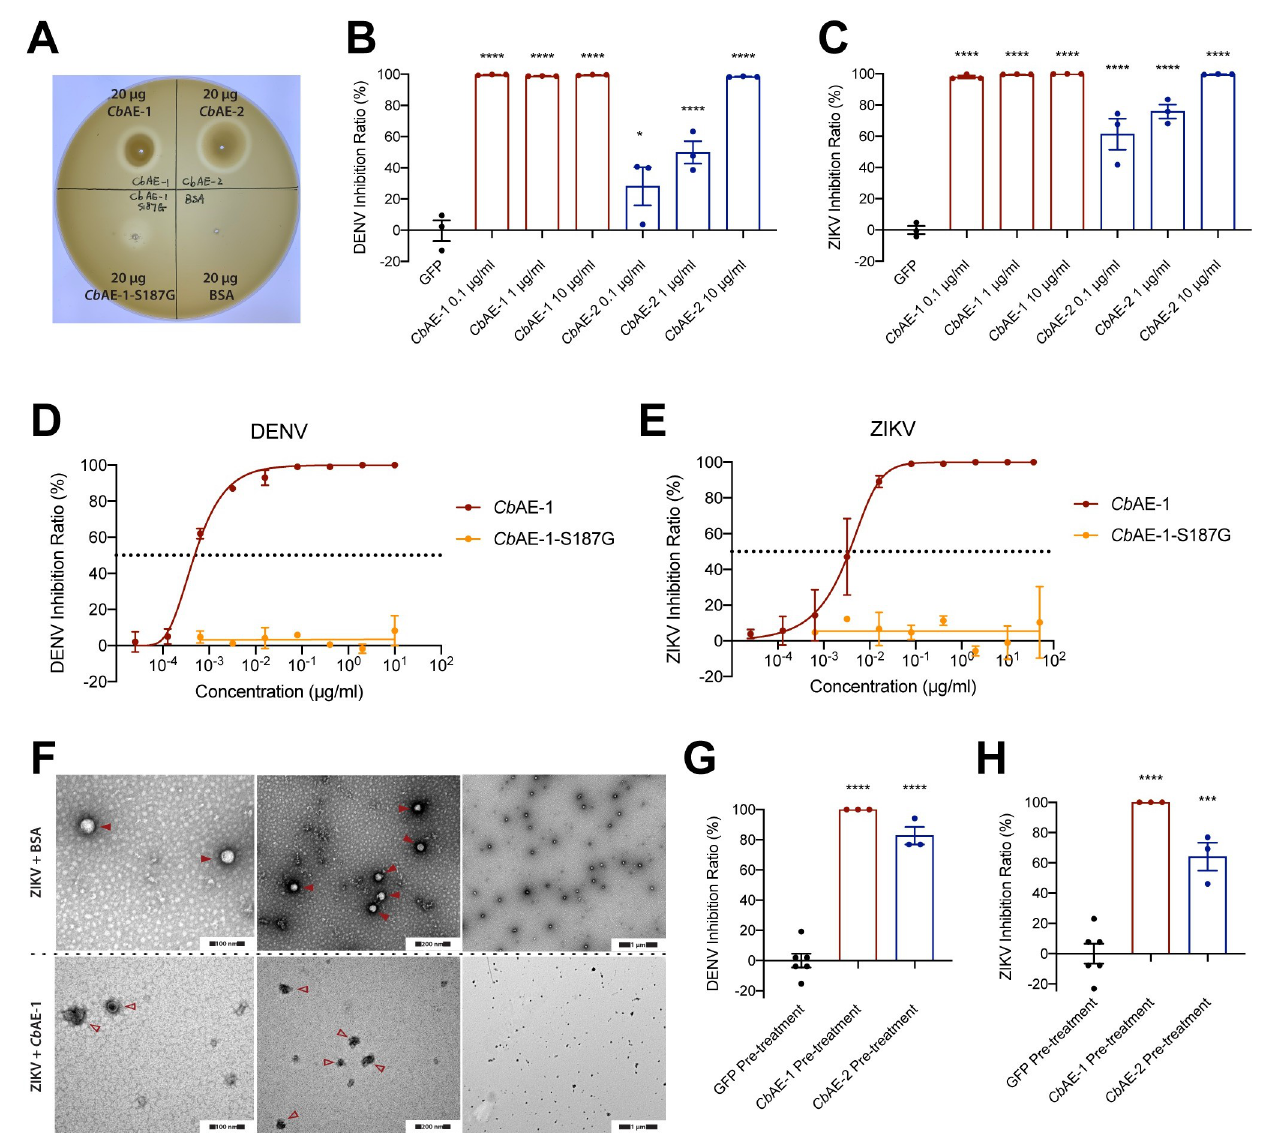
Fig 4. The virucidal activity of Cb AEs is mediated by enzymatic degradation of the viral lipidic envelope. (A) Lipase enzymatic activity of Cb AE-1, Cb AE-2 and Cb AE-1-S187G measured via an egg yolk agar plate assay. (B, C) Analysis of the exposure of DENV (B) or ZIKV (C) genomic RNA. DENV or ZIKV was first treated with serial concentrations of Cb AE-1, Cb AE-2 and then with RNase-A. Viral RNA degradation was evaluated by RT–qPCR. (D, E) The S187G mutant of Cb AE-1 fully lost its ability to suppress DENV (D) and ZIKV (E) infection: inhibition curves of Cb AE-1 and Cb AE-1-S187G against DENV (D) or ZIKV (E). Serial concentrations of Cb AE-1 or Cb AE-1-S187G were mixed with 50 PFU of DENV or ZIKV in VP-SFM medium to perform standard plaque reduction neutralization tests (PRNTs). (F) Representative negative stained transmission electron microscopy images of ZIKV particles treated with 10 μ g/mL BSA (arrowhead) and those treated with 10 μ g/mL Cb AE-1 (empty arrowhead); high magnification: 240,000 × , medium magnification: 120,000 × , low magnification: 30,000 × . (G, H) Rate of DENV (G) or ZIKV (H) replication inhibition following exposure to Cb AEs before viral infection of Vero cell monolayers. The viral genome was quantified by RT–qPCR. (B, C, G, H) Significance was determined using unpaired t tests. Data are presented as the mean ± SEM. P values were adjusted using Dunnett’s test to account for multiple comparisons. The P value represents a comparison between the control group and the other groups. �� P < 0.01, ��� P < 0.001, ���� P < 0.0001. Experiments consisted of at least three biological replicates with similar